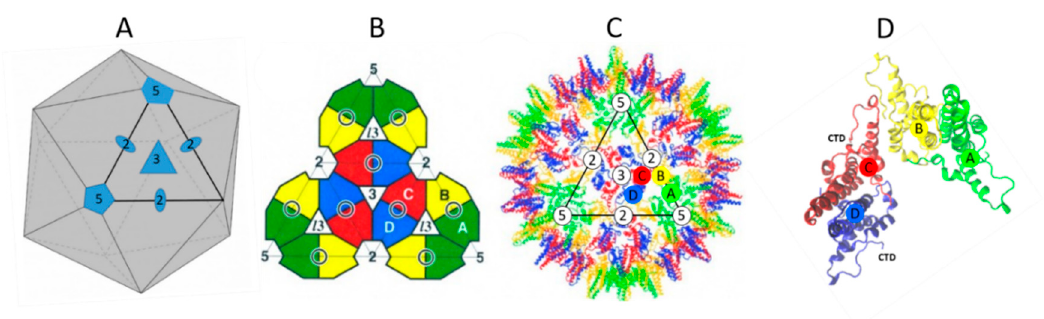
Figure 4. Dimer assembly in the T = 4 capsid. The HBV capsid structure was generated from cryo-electron microscopy (cryo-EM) analyses and X-ray crystallography (XR) with HBc proteins produced in vitro or from HBV-infected persons [23]. ( A ): Scheme of an icosahedron (adapted from [32]). It contains 20 facets (triangle) with the threefold axes going through the center of the opposite face, twelve fivefold axes (pentagon) going through the opposed vertices and fifteen twofold axes (oval) passing though the centers of the opposite vertices. ( B ): View of one icosahedron face through the threefold axis [24]. A, B, C and D correspond to 2 × 2 dimers and the central black ring corresponds to the four helix bundles. Subunit nomenclature and color were used according to [27,32]. ( C ): Structure of HBV capsid (T = 4) viewed from the threefold axis [24]. ( D ): A–B and C–D HBc dimers oriented to form the T = 4 capsid. These structures were obtained from the PDB, file 1QGT, and colored by using visual molecular dynamics (VMD) 1.9.3.